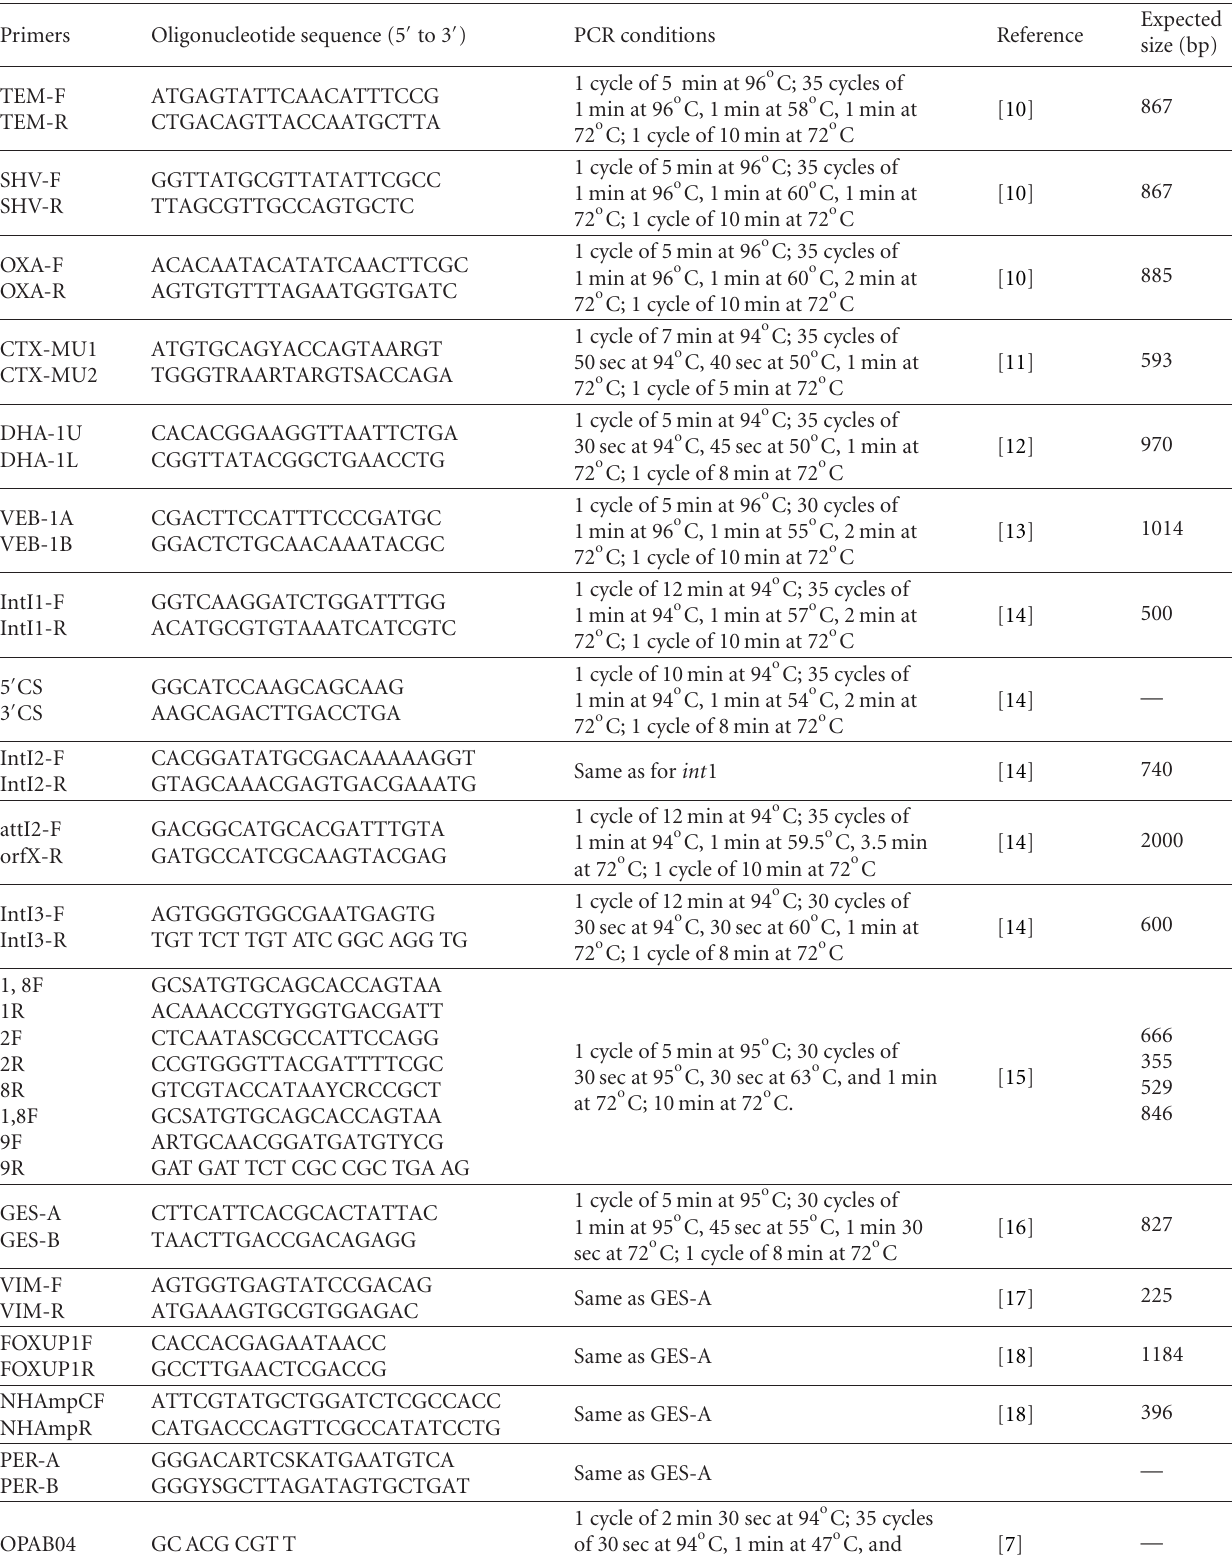
Table 1: Primer sequences and PCR